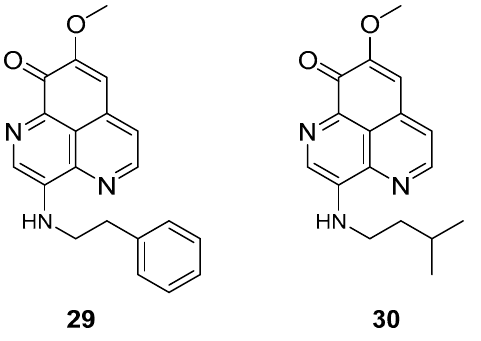
Figure 12. Structures of 3-(phenetylamino)dimethyl(oxo)aaptamine ( 29 ) and 3-(isopentylamino)dimethyl (oxo)aaptamine ( 30 ).